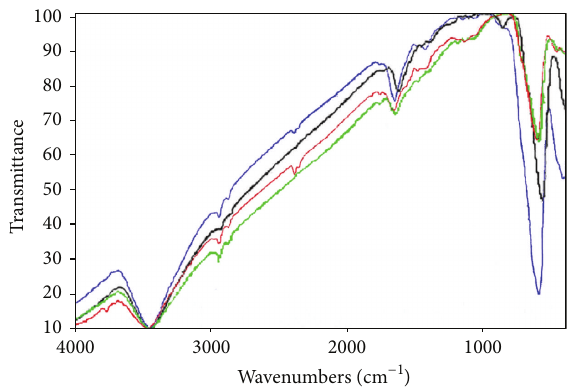
Figure 3: Infrared spectra of magnetite nanoparticles prepared at different temperatures: (blue A1) 273 K; (red A2) 283 K; (green A3) 293 K; and (black A4) 303 K.